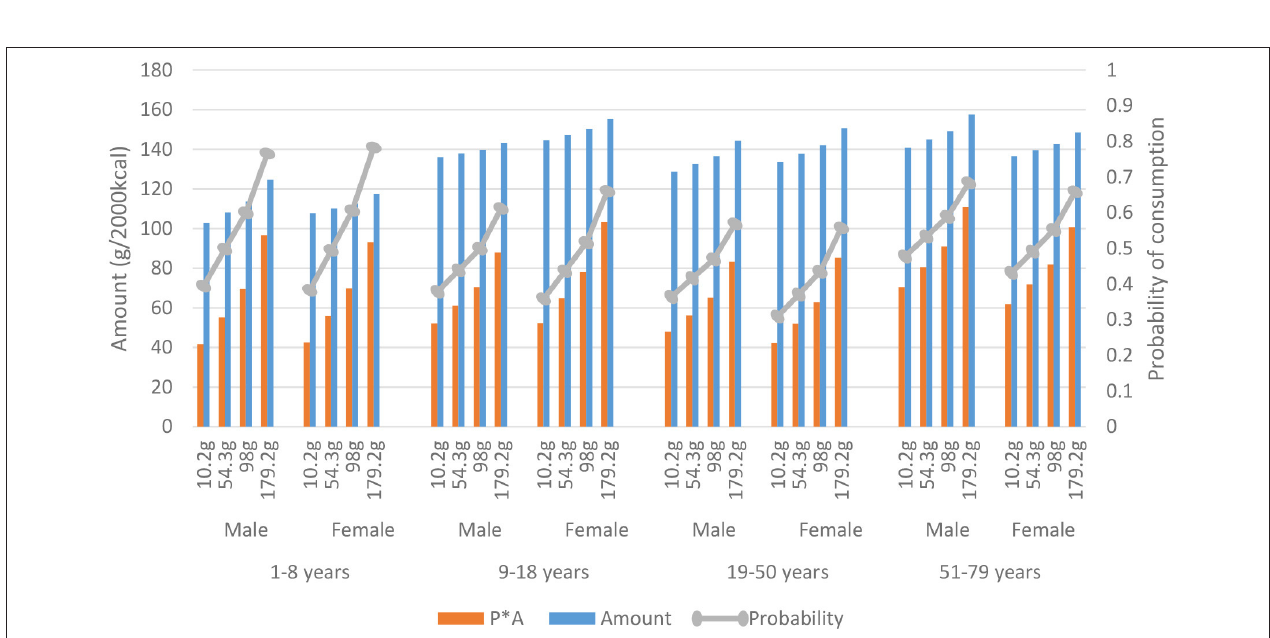
FIGURE 3 | Difference in predicted quantity (g/2,000 kcal) between the highest and lowest quartile of meat consumption, divided by the mean of the corresponding age and gender group, per solid food group, and milk in the observed diets in the Dutch National Food Consumption Survey 2012–2016, stratified by age, corrected for sex and the interaction between sex and meat consumption.